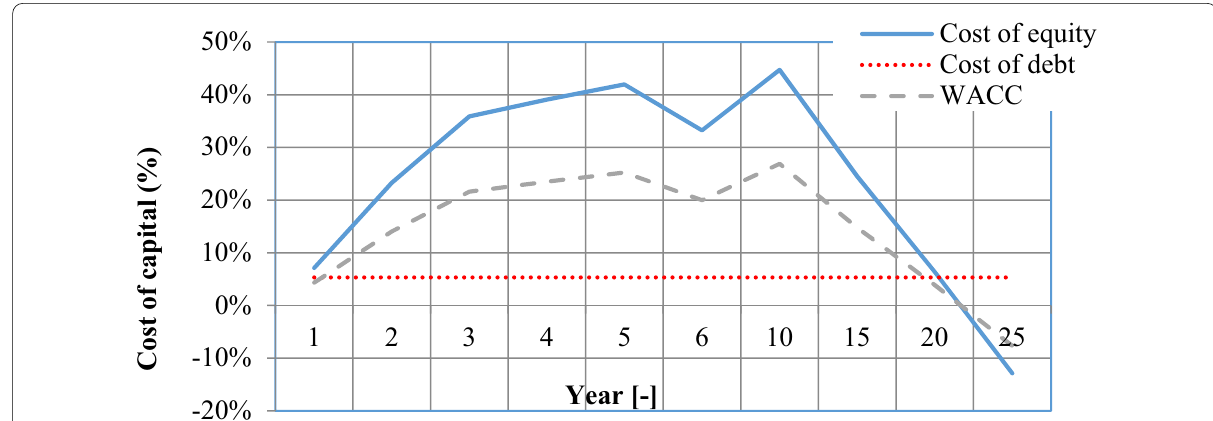
Fig. 12 Comparison of equity and debt cost of capital with weighted average cost of capital